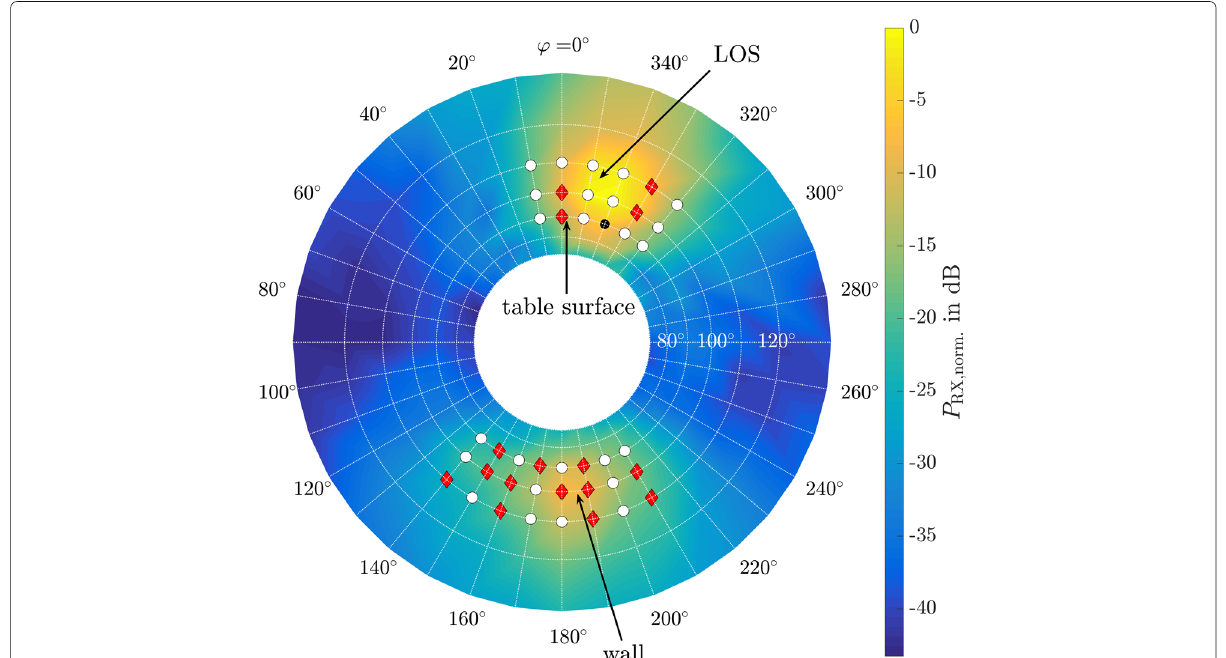
Fig. 10 Estimated directional receive power of MC2. Due to the elevated position of the steerable horn antenna, two interacting objects from Fig. 7, namely the desk and the fridge, are no longer visible. LOS and the wall reflection are still present. These regions are the only ones which are spatially sampled. Markers have the same meaning as in Fig. 7